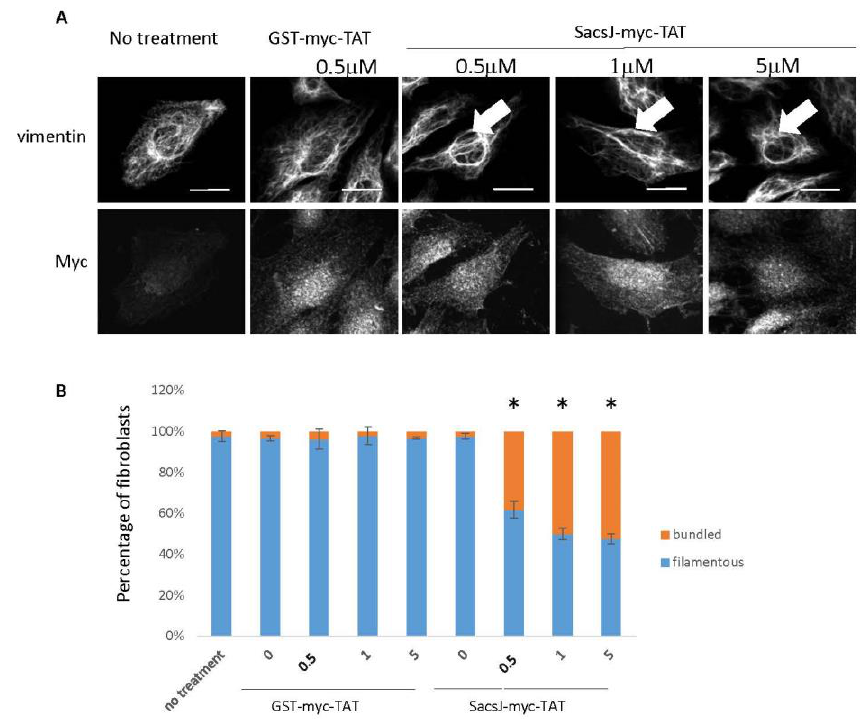
Figure 5. The cell-permeant peptide, Sacs-myc-TAT, induced step-wise disruption of the vimentin IF network in MCH74 fibroblasts. ( A ) Representative 3-dimensional reconstructions of Z-stack confocal images of MCH74 fibroblasts double labelled with anti-myc (rabbit anti-myc) and anti-vimentin (V9 mouse monoclonal) treated with increasing concentrations of Sacs-myc-TAT as indicated (0.5 to 5 µ M) or control peptide GST-myc-TAT. Treatment with Sacs-myc-TAT for 30 min resulted in nuclear rings of bundled vimentin IF (large arrow). Scale bar: 20 µ m. ( B ) Quantitation of the percentage of fibroblasts presenting circum-nuclear IF bundles or finely distributed IF when treated with increasing concentrations of Sacs-myc-TAT (0.5 to 5 µ M) showing an increase in the percentage of cells with IF concentrated surrounding the nucleus. * p < 0.05 vs. NFL alone, one-way ANOVA ( n = 3). Note the diffuse distribution of labelling of the myc tag on